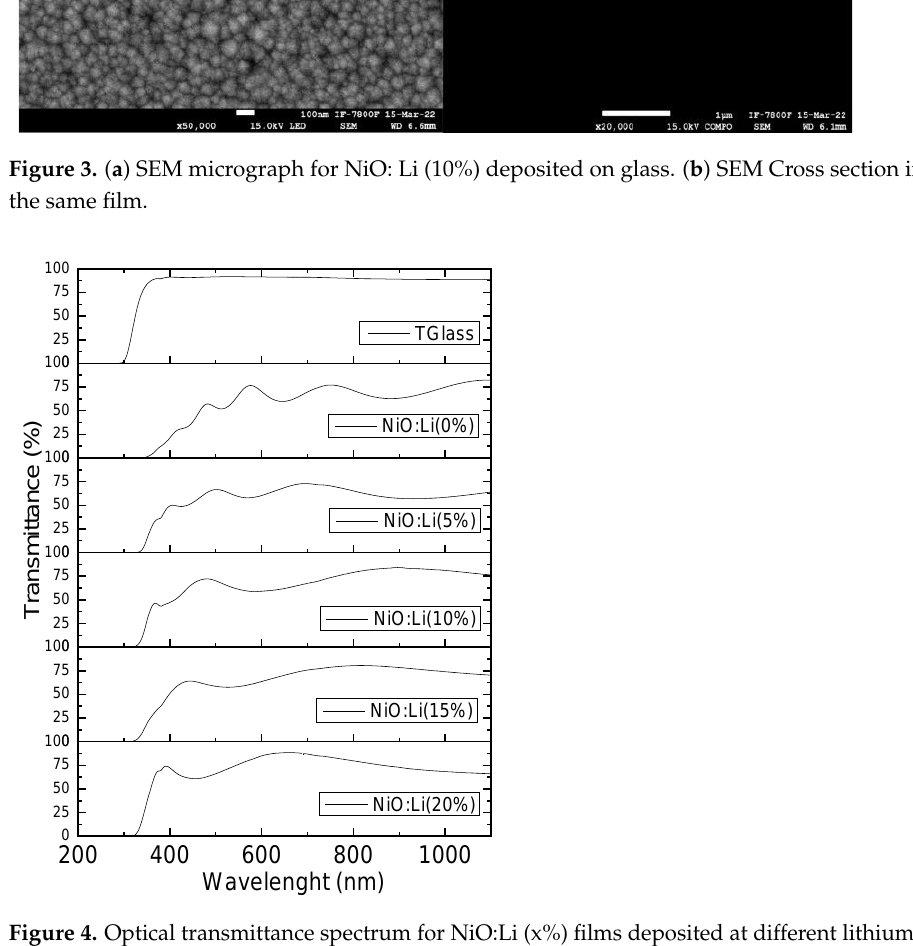
Figure 4. Optical transmittance spectrum for NiO:Li (x%) films deposited at different lithium concen- trations. The spectrum at the top is the transmittance of the glass substrate.